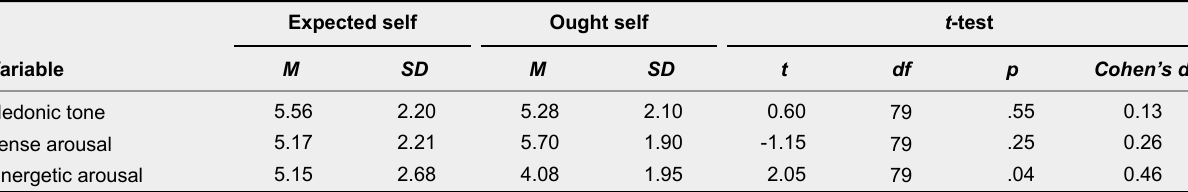
The t-Test for the Mood Variables